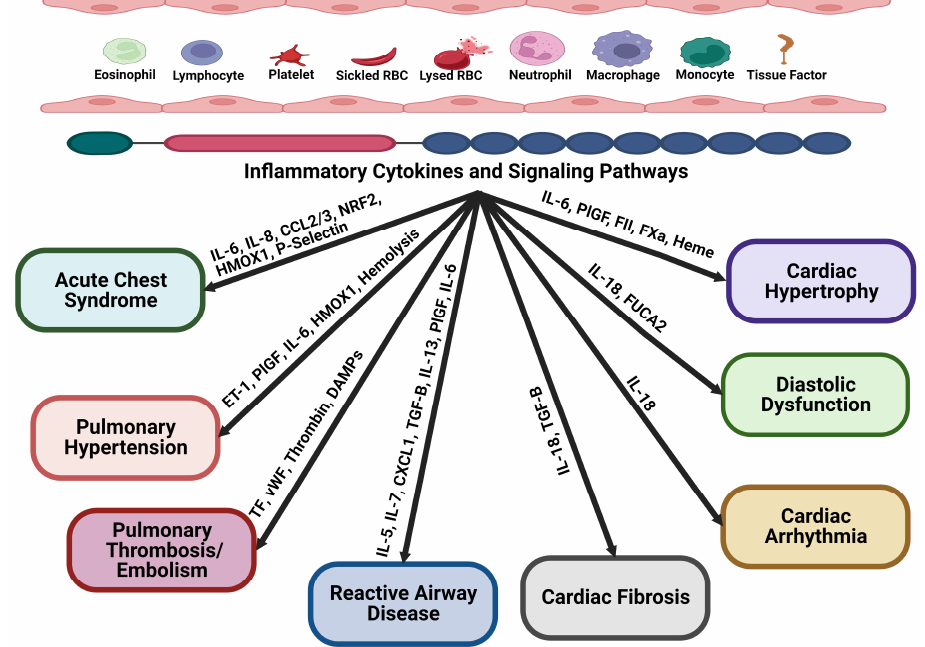
Figure 1. A visual representation of the inflammatory mediators that may be involved in the cardiopulmonary complications of sickle cell disease. Interleukin 6 (IL-6), IL-5, IL-7, IL-18, IL- 13, Tissue factor (TF), C-C motif chemokine ligand 2 (CCL2/3), reactive oxygen species (ROS), nuclear-factor erythroid 2 like 2 (NRF2), heme-oxygenase 1 (HMOX1), endothelin-1 (ET-1), placental growth factor (PlGF), von Willebrand factor (VWF), danger-associated molecular patterns (DAMPs), chemokine (C-X-C motif) ligand 1 (CXCL1), Factor II (FII), Factor Xa (Fxa), and transforming growth factor (TGF- β